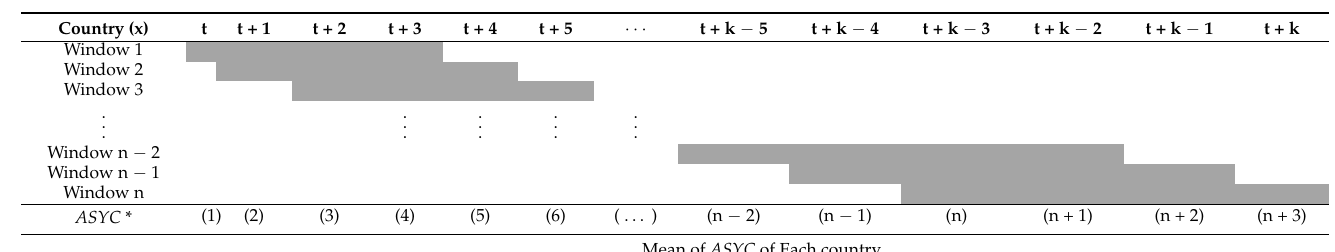
Table 1. Window DEA